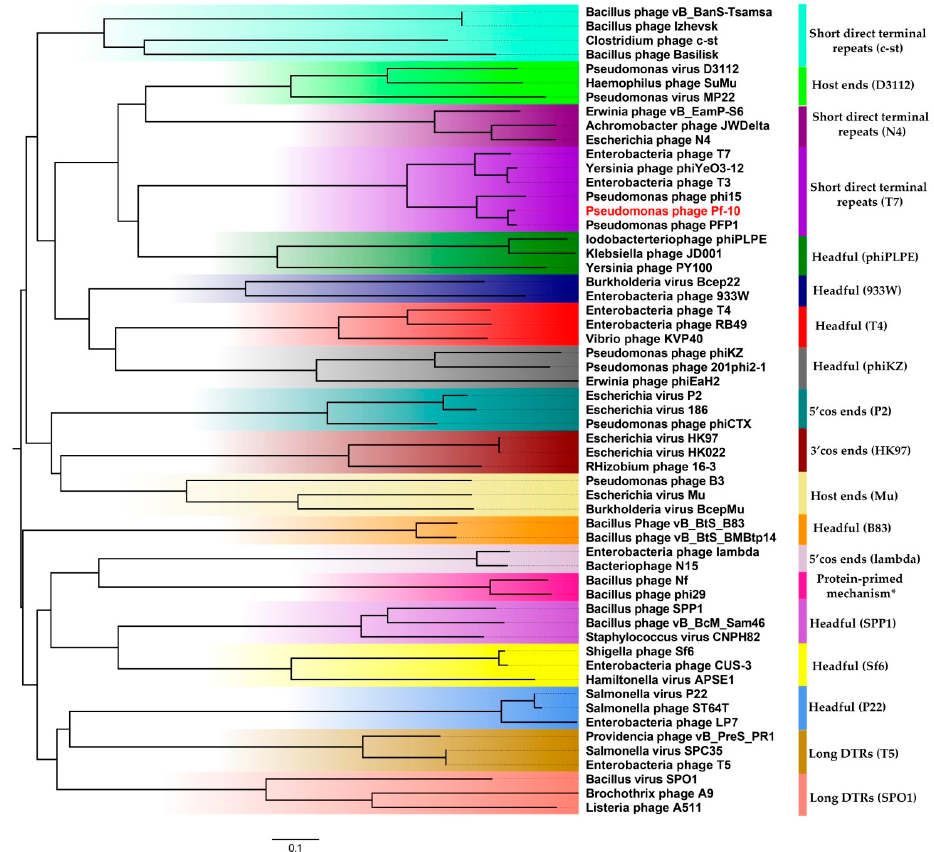
Figure 7. The phylogenetic tree based on the amino acid sequence of large terminase subunits using the proteins from the phage Pf-10 and from phages with well-known packaging mechanisms. The phylogenetic tree was constructed from MAFFT alignments using MEGA X by the neighbor-joining method with a bootstrapping of 100 and displayed using FigTree